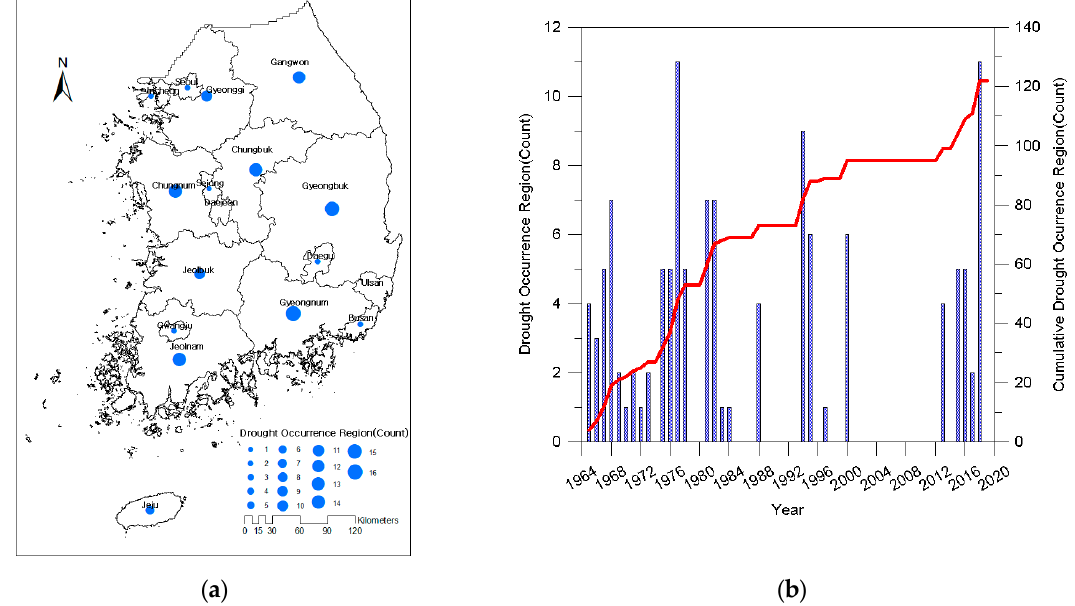
Figure 2. Drought damage status in South Korea (1965 to 2018): ( a ) Number of drought damage occurrences by region; ( b ) Number of drought damage occurrences by year.